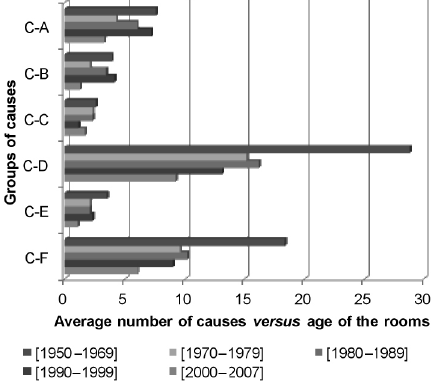
Fig. 9. Average number of causes versus age of the